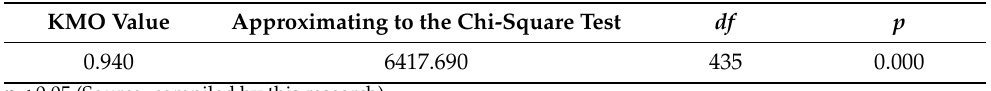
Table 6. Bartlett’s test of sphericity and the KMO value. KMO Value Approximating to the Chi-Square Test df p 0.940 6417.690 435